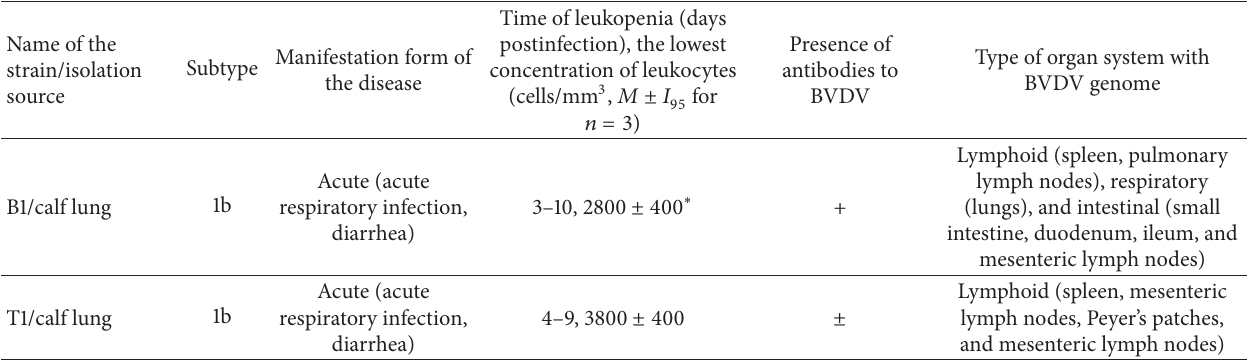
Table 2: Pathogenic properties of bovine viral diarrhea virus (BVDV) cytopathic strains of type 1 after aerosol challenge of 4–6-month-old calves with the dose of 6 log 10 TCD 50 .